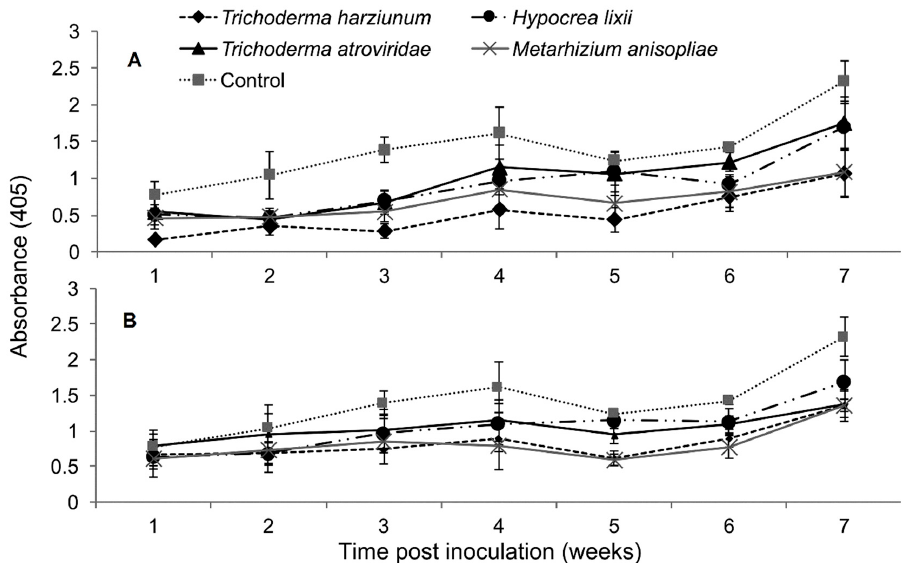
Figure 5. Titer levels of Sugarcane mosaic virus estimated over time in maize through ELISA as influenced by different treatments in trials one ( A ) and two ( B ) .